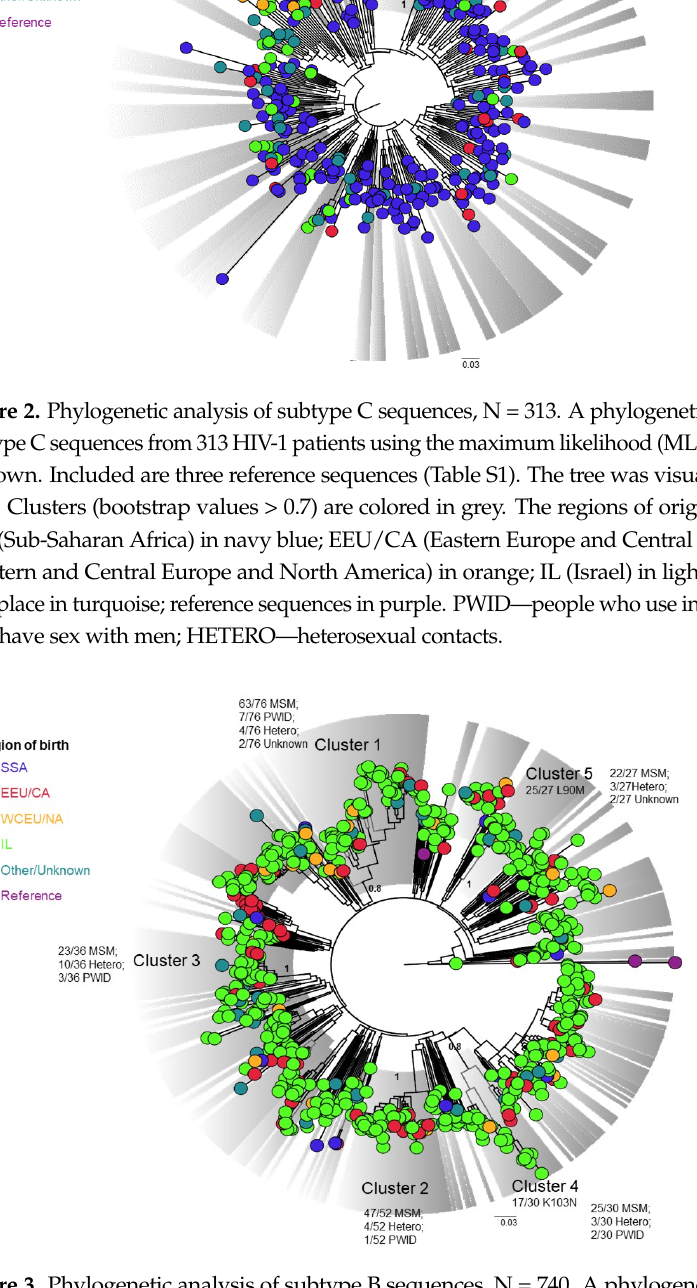
Figure 4. Phylogenetic analysis of subtype A sequences, N = 482. A phylogenetic tree of the pol region of subtype A sequences from 482 HIV-1 patients using the maximum likelihood (ML) with GTR + G + I model is shown. Included are three reference sequences (Table S1). The tree was visu- alized in Fig Tree version 1.4.4. Clusters (bootstrap values >0.7) are colored in grey. Countries of origin are colored as follows: SSA (Sub-Saharan Africa) in navy blue; EEU/CA (Eastern Europe and Central Asia) in red; WCEU/NA (Western and Central Europe and North America) in orange; IL (Israel) in light green; other/unknown birthplace in turquoise; reference sequences in purple.